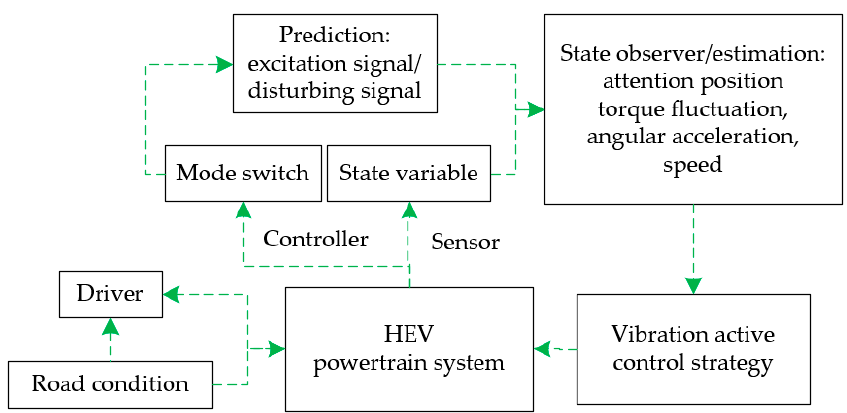
Figure 4. Torsional vibration active control strategy diagram.